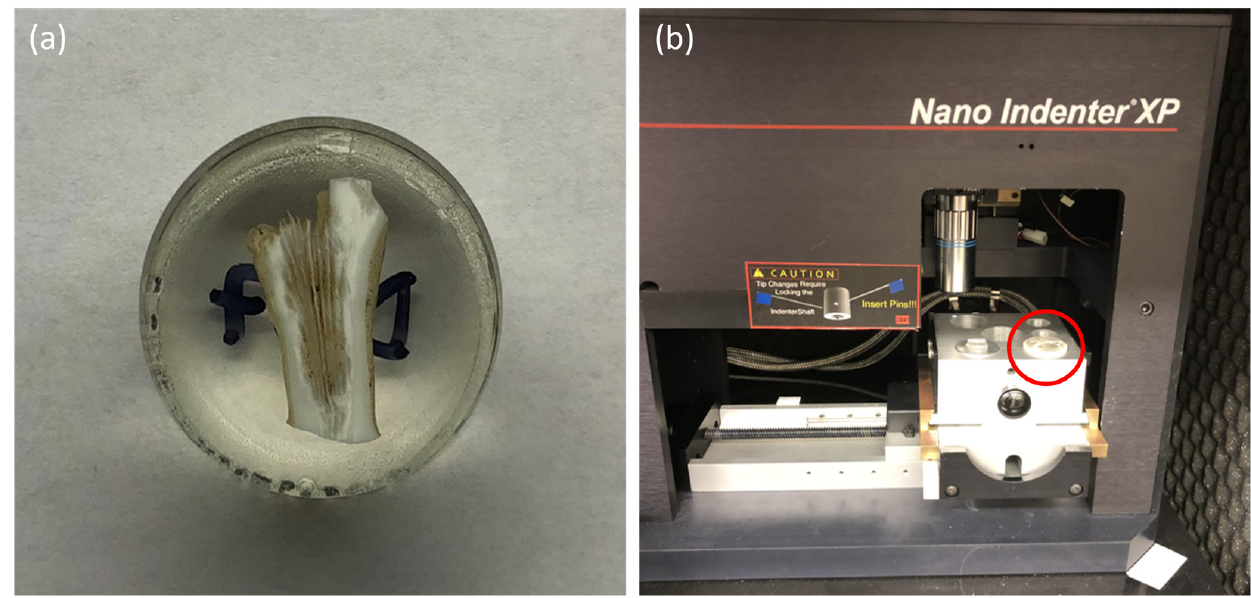
Figure 2. Preparation of coral sample ( a ) Desmophyllum pertusum set in resin, cut and polished with exposed skeleton prior to nanoindentation, and ( b ) a prepared coral sample in the mount (red circle) of the MTS Nano Indenter ® XP (Dublin, Ireland).